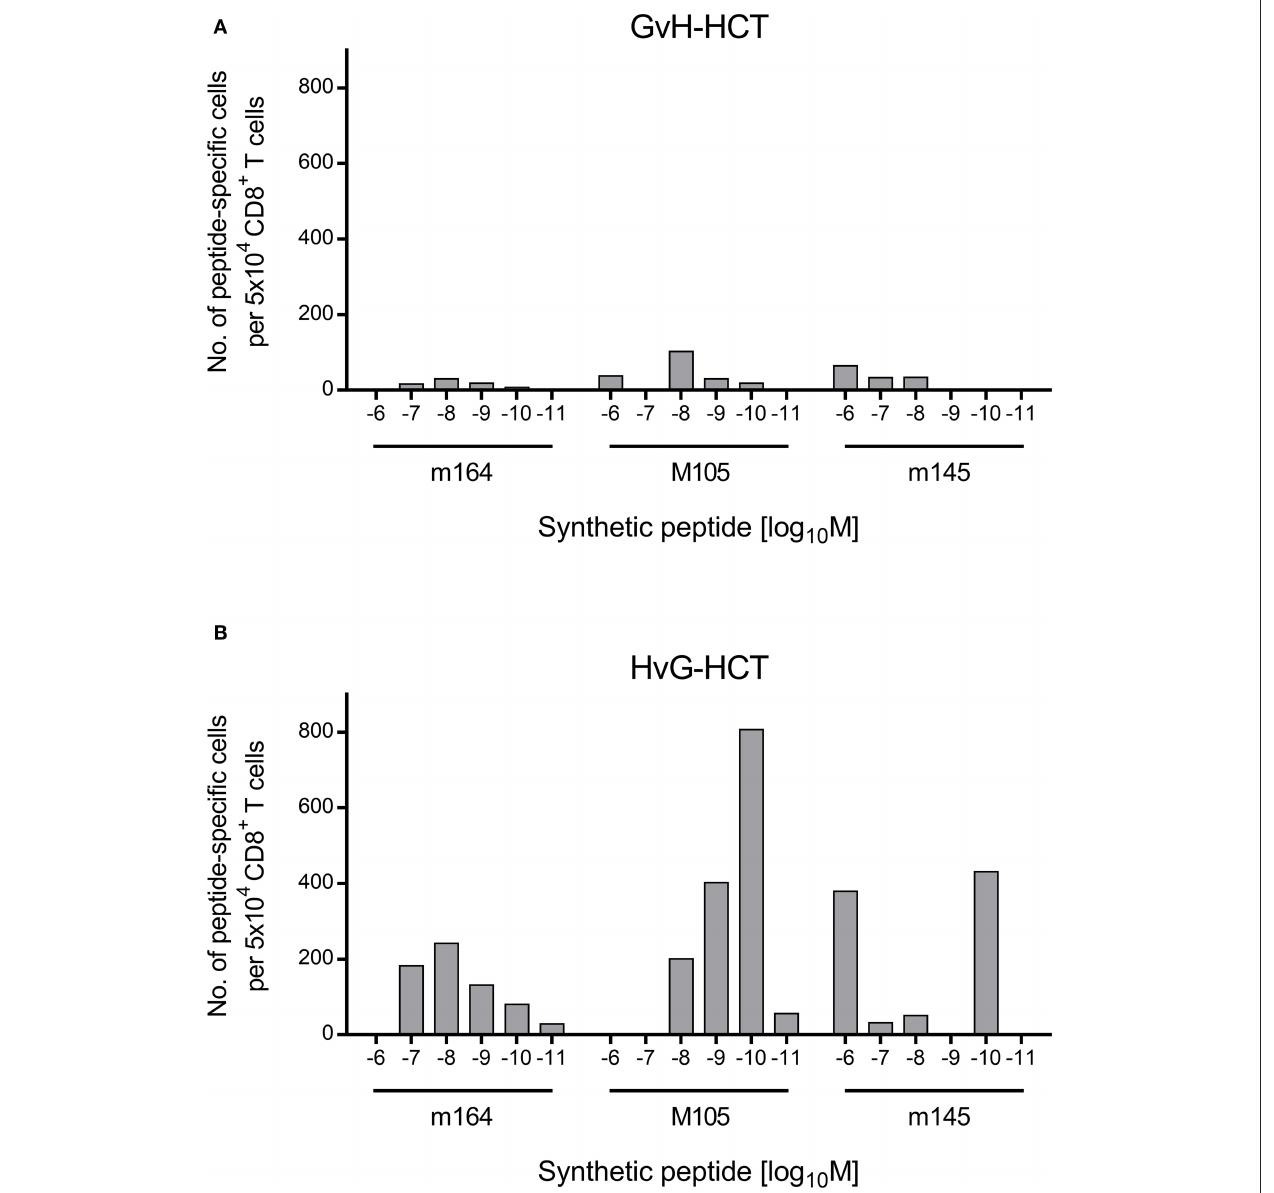
FIGURE 8 | Gaussian-like avidity distributions of liver-infiltrating viral epitope-specific CD8 + T cells. (A) GvH-HCT. (B) HvG-HCT. Data of the experiment shown in Figure 7 are rearranged to reveal the non-cumulative avidity distributions that represent numbers of cells responding precisely to the indicated peptide-loading concentration (for the calculation method, see Holtappels et al.,